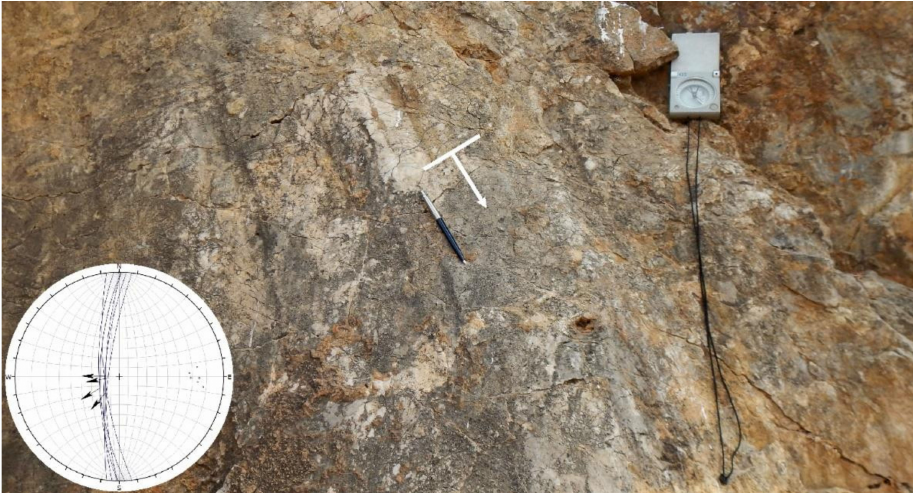
Figure 5. Fault plane of a Kastelli fault segment measured at 74/263, on which striations measured at 61/220 were found (parallel to the pen), confirming the oblique normal movement with left-lateral component. Measurements at several places are plotted in the inset